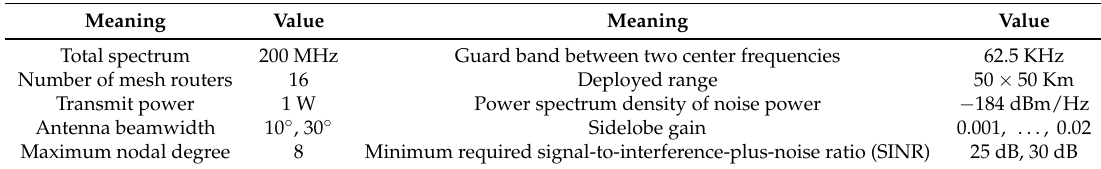
Figure 4. Network topology of our simulations. Table 1. Main simulation parameters used in the